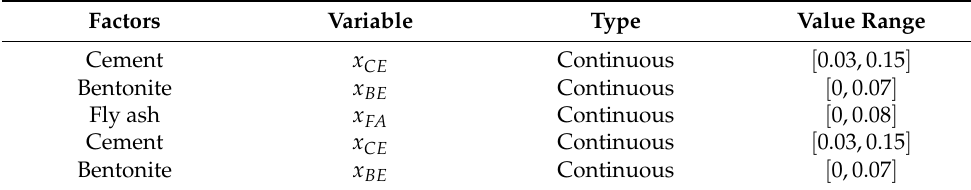
Table 4. Decision variables.